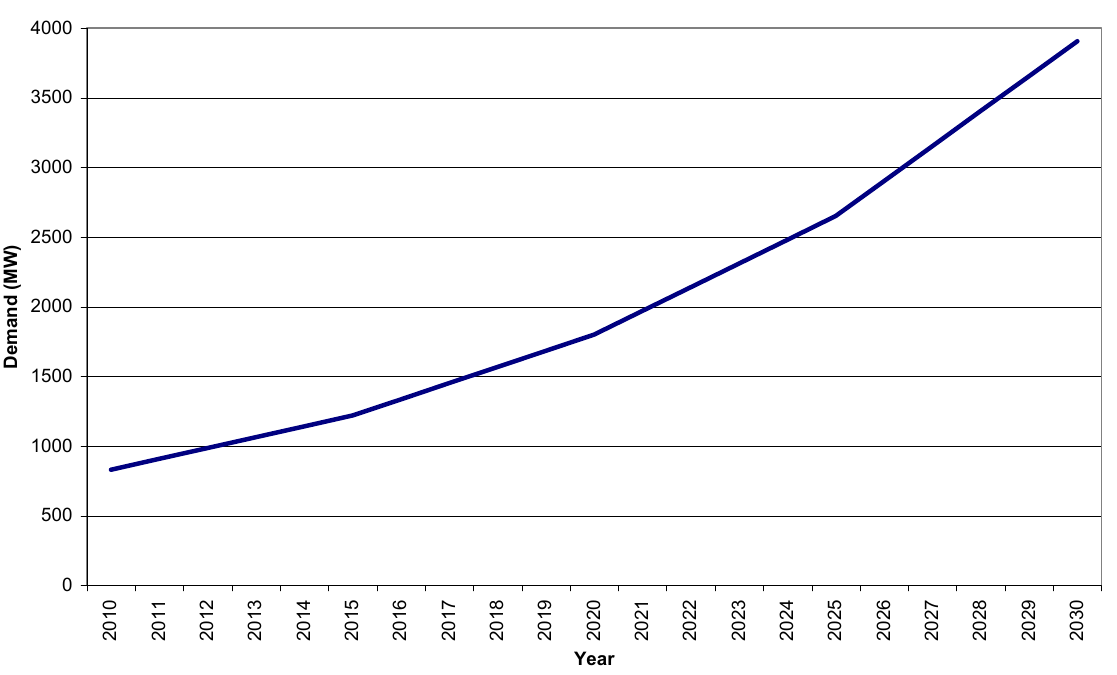
Figure 2. Sabah power demand